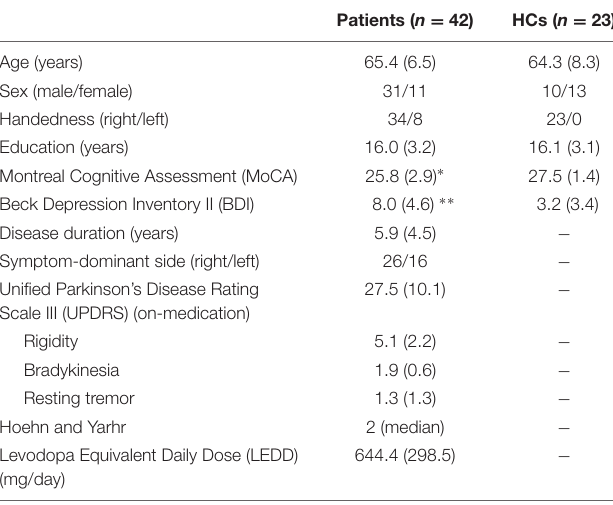
TABLE 1 | Demographic and clinical characteristics of patients with Parkinson’s disease (PD) and healthy controls (HCs). Patients ( n = 42)